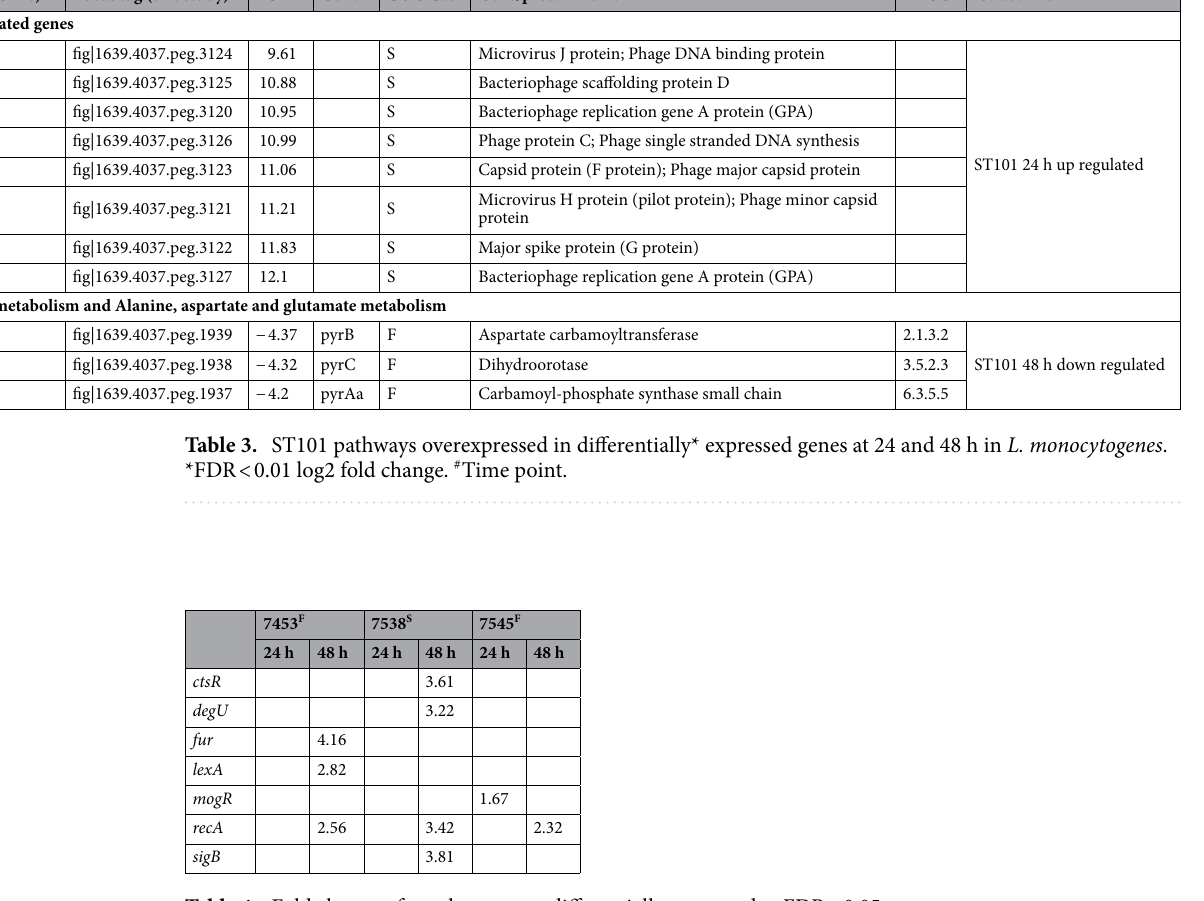
Table 4. Fold change of regulator genes differentially expressed at FDR <